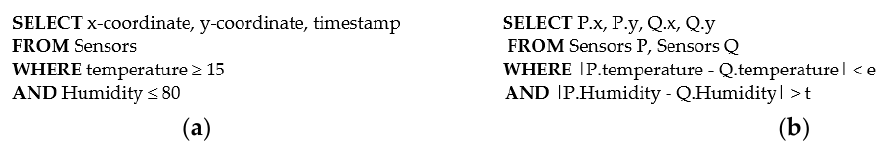
Figure 3. Examples of SQL-like queries in WSNs.